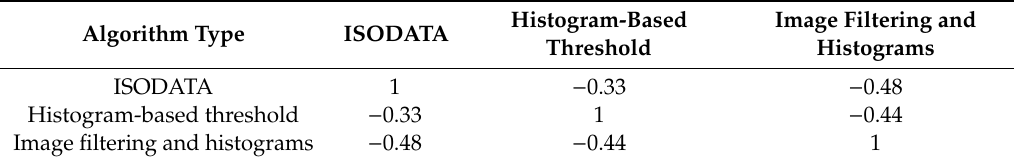
Table A6. The Pearson correlation coe ffi cients of the di ff erent image binarization algorithm using FID. It confirms that our sample accuracy was independent.